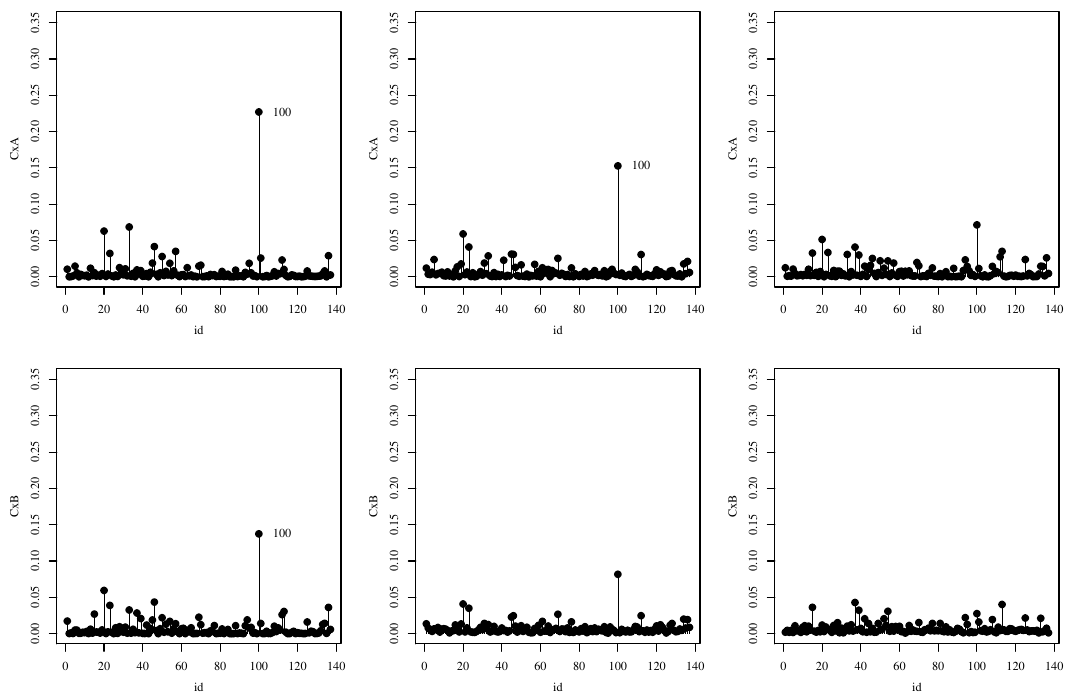
Figure A3. The index plots of C i for (cid:98) β ( upper ) and (cid:98) ν ( lower ) under the weight perturbation ( left ), response perturbation ( center ), and covariate perturbation ( right ) schemes for the RPGJSB2 q model with q = 0.75 (link loglog and G the cdf from the normal model) of the COVID-19 data